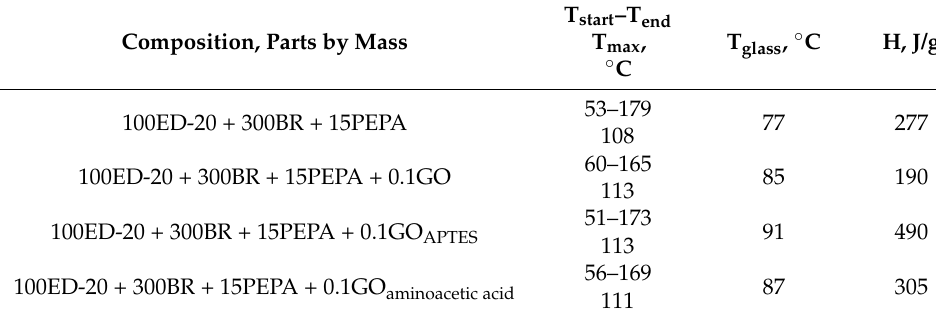
Figure 7. DSC data of epoxy composite: 1—original composite; 2—composite with 0.1 part by mass of GO; 3—composite with 0.1 part by mass of GO functionalized with aminoacetic acid; 4—composite with 0.1 part by mass of GO functionalized with APTES. Table 3. Values of curing indices by differential scanning calorimetry.